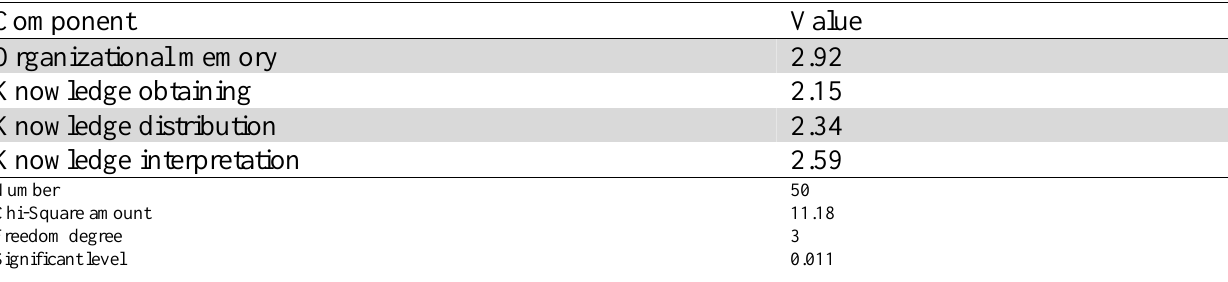
The results of Friedman test for ranking organizational learning aspects Component Organizational